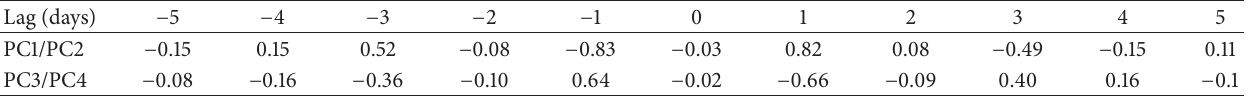
Figure 2: Spatial patterns of the first four leading EOF modes of the synoptic-scale eddy at 850 hPa in winter from 1948 to 2010 ((a) EOF1, (b) EOF2, (c) EOF3, and (d) EOF4, unit: gpm). Table 1: Lead and lag correlation coefficient among